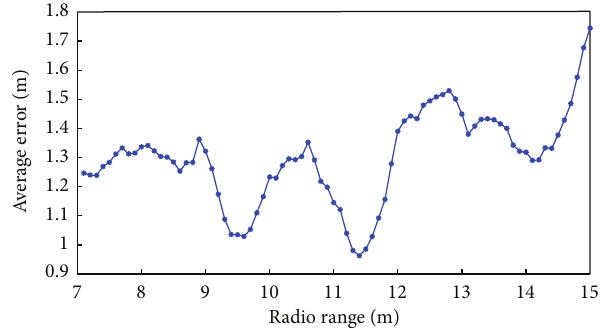
Figure 7: The average estimated error with different sensing radii for path 2 movement.